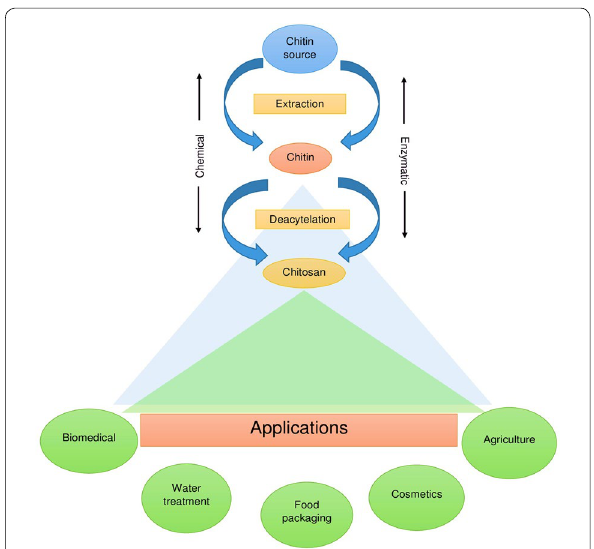
Fig. 7 Preparation of chitin and chitosan from natural resources and their